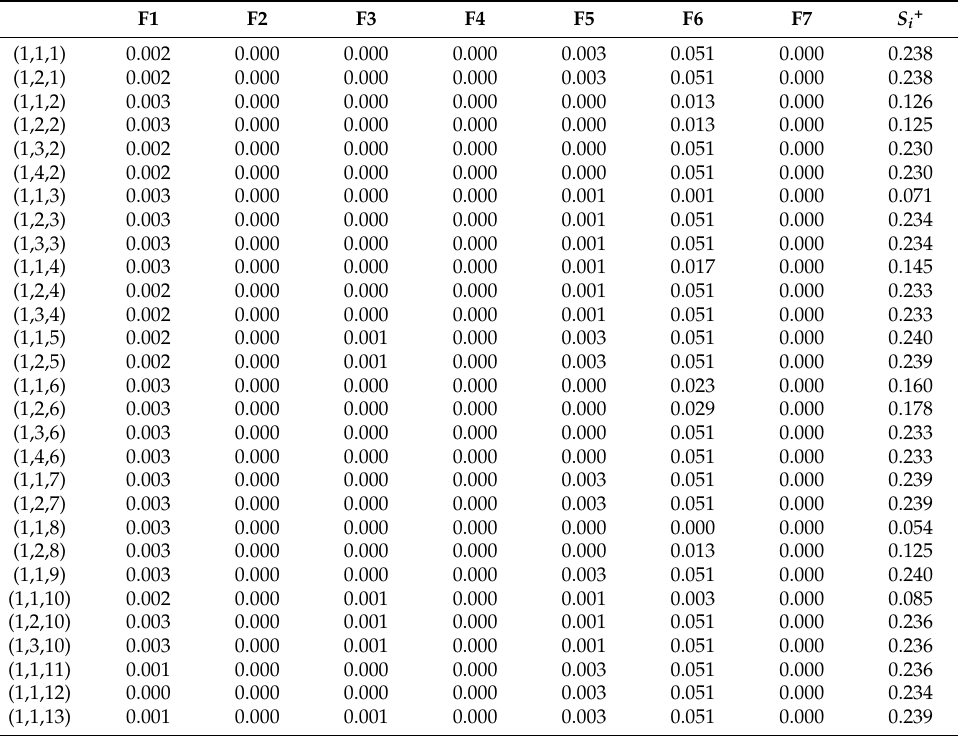
Table A10. Total separation of eligible operations from the ideal scenario—1st iteration.